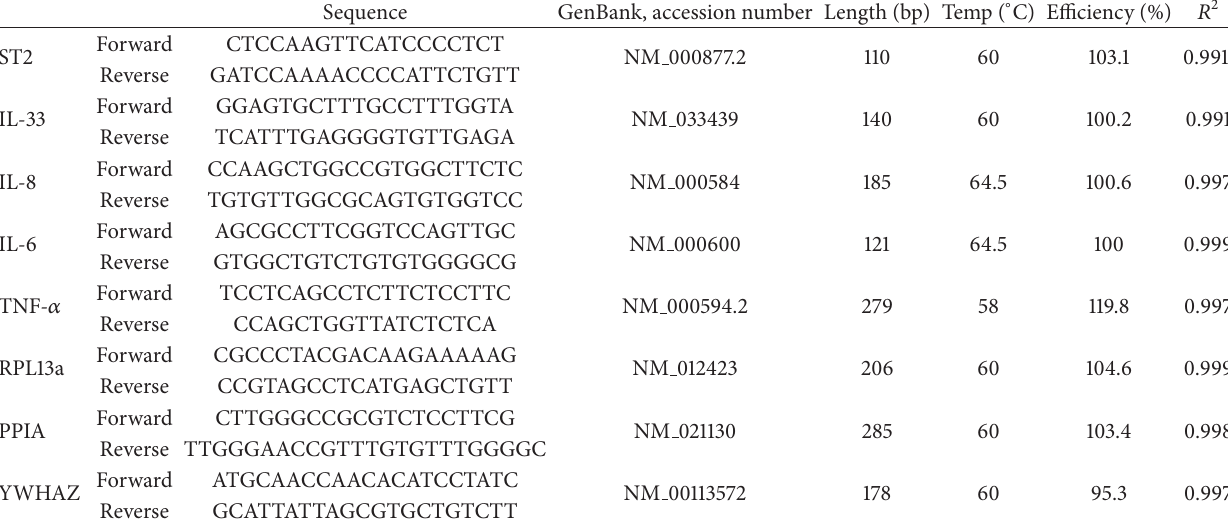
Table 1: Analytical details of gene primers for real-time PCR